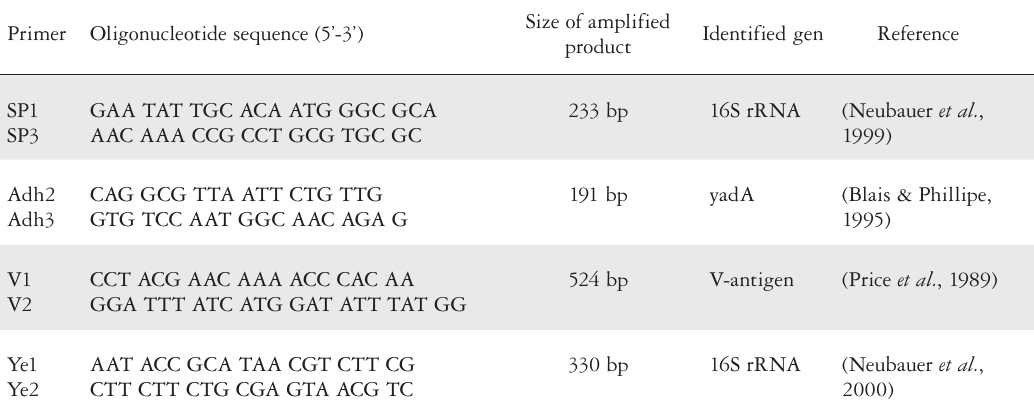
Table 2. Primers used in the PCR to amplify Yersinia -genes. Primer Oligonucleotide sequence